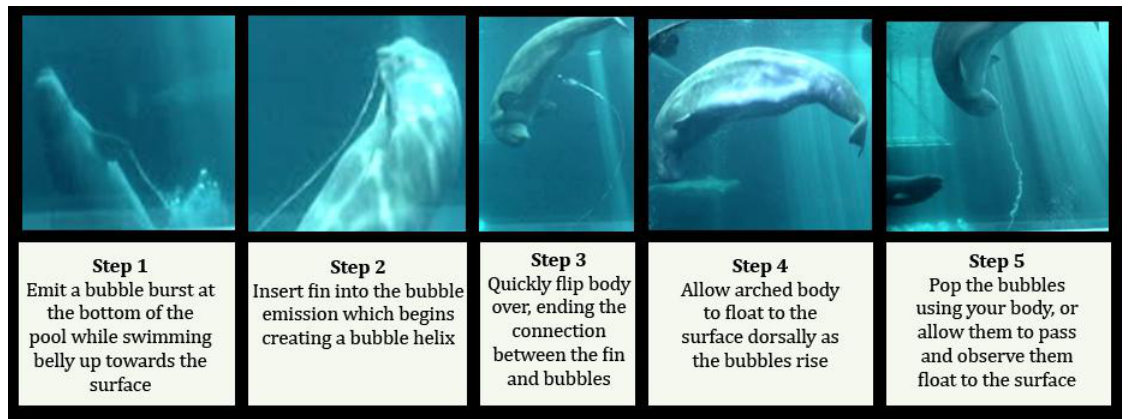
Figure 1 . Beluga Helix Play Behavior Sequence. This shows the typical sequence of behaviors involved in bubble helix play